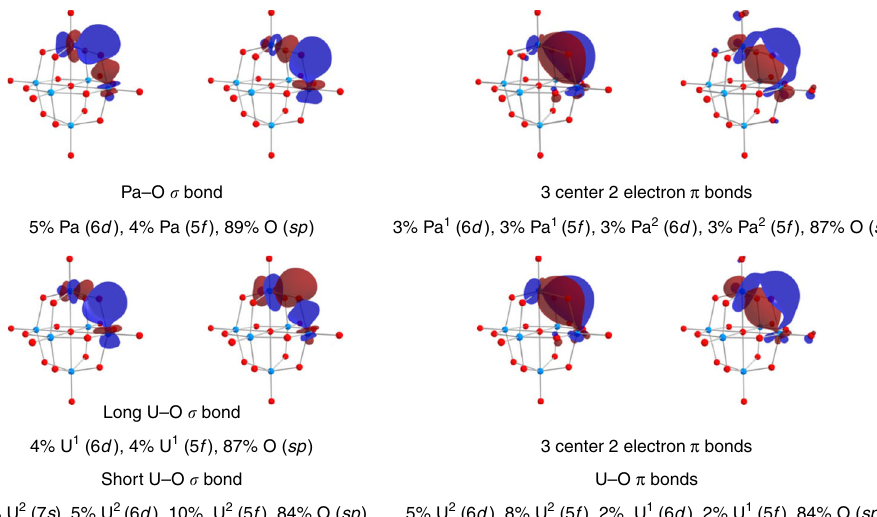
Fig. 4 Plots of the natural localized molecular orbitals of the calculated Pa and U hexametalates. The oxidation state of the U(V) hexametalate was veri fi ed at the end of the calculation. The atomic orbital contributions to the localized natural molecular orbitals are provided. The isosurface cutoff is 0.03. The metal atoms are turquoise spheres and the oxygen in